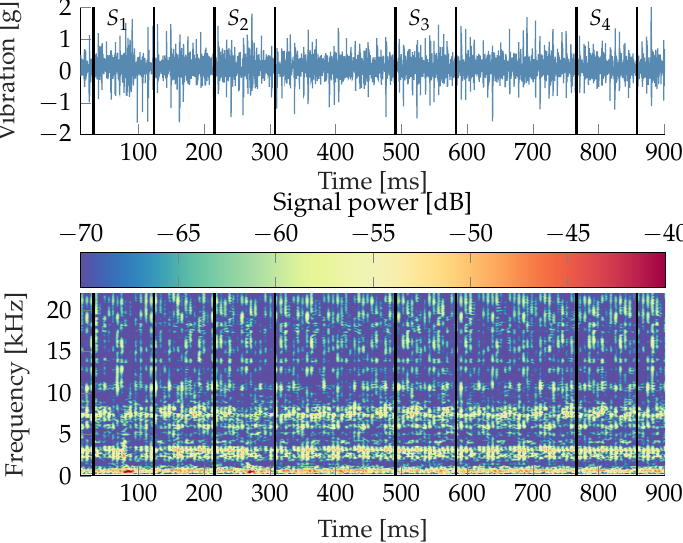
Figure 7. Vibration signal and spectrogram of the artificially damaged gear z 3